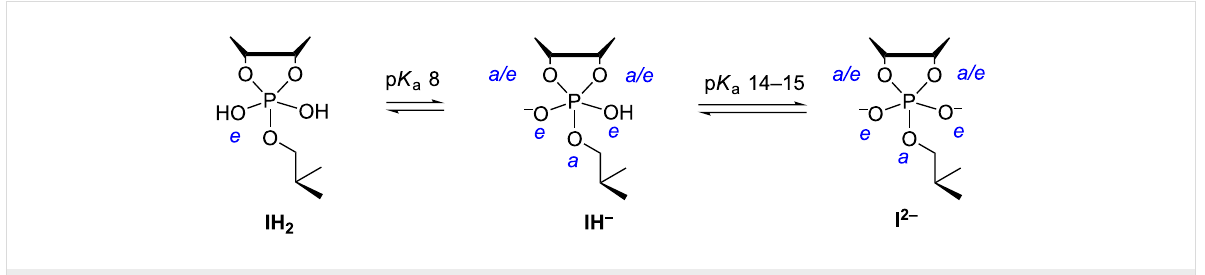
Figure 4: Protolytic equilibria of phosphorane intermediate of RNA transesterification.